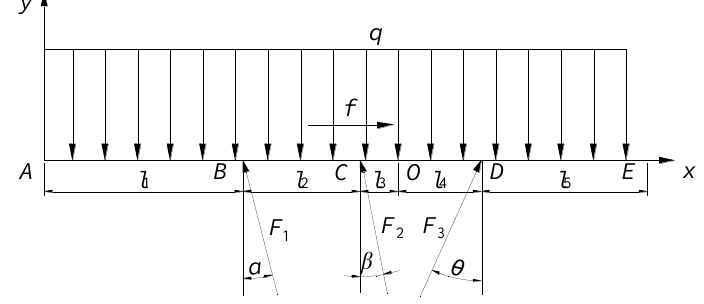
Figure 8. Backfilling hydraulic support with a uniform external load on the top beam.